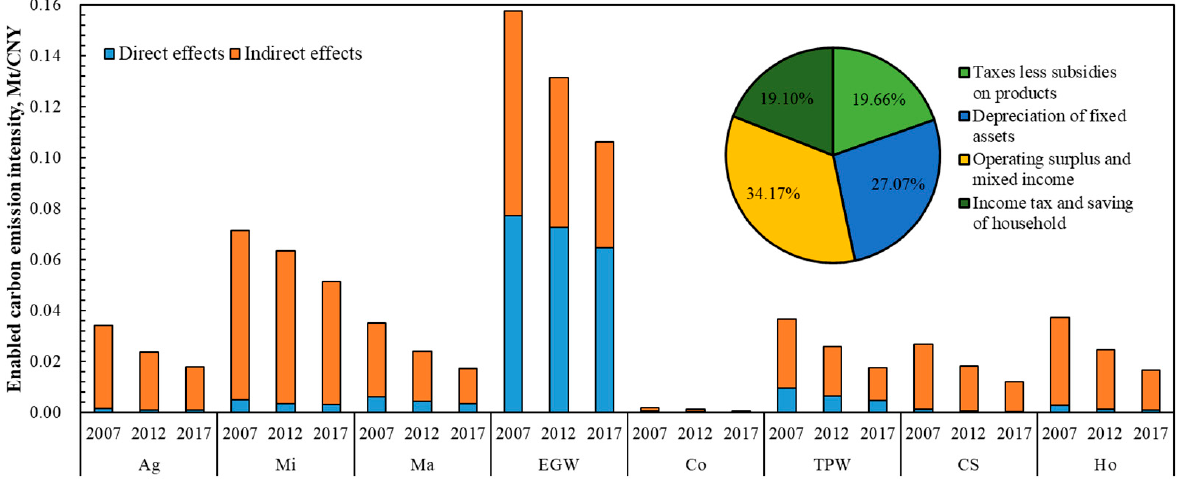
Figure 1. Sectoral carbon emission intensity and carbon emissions enabled by primary inputs.